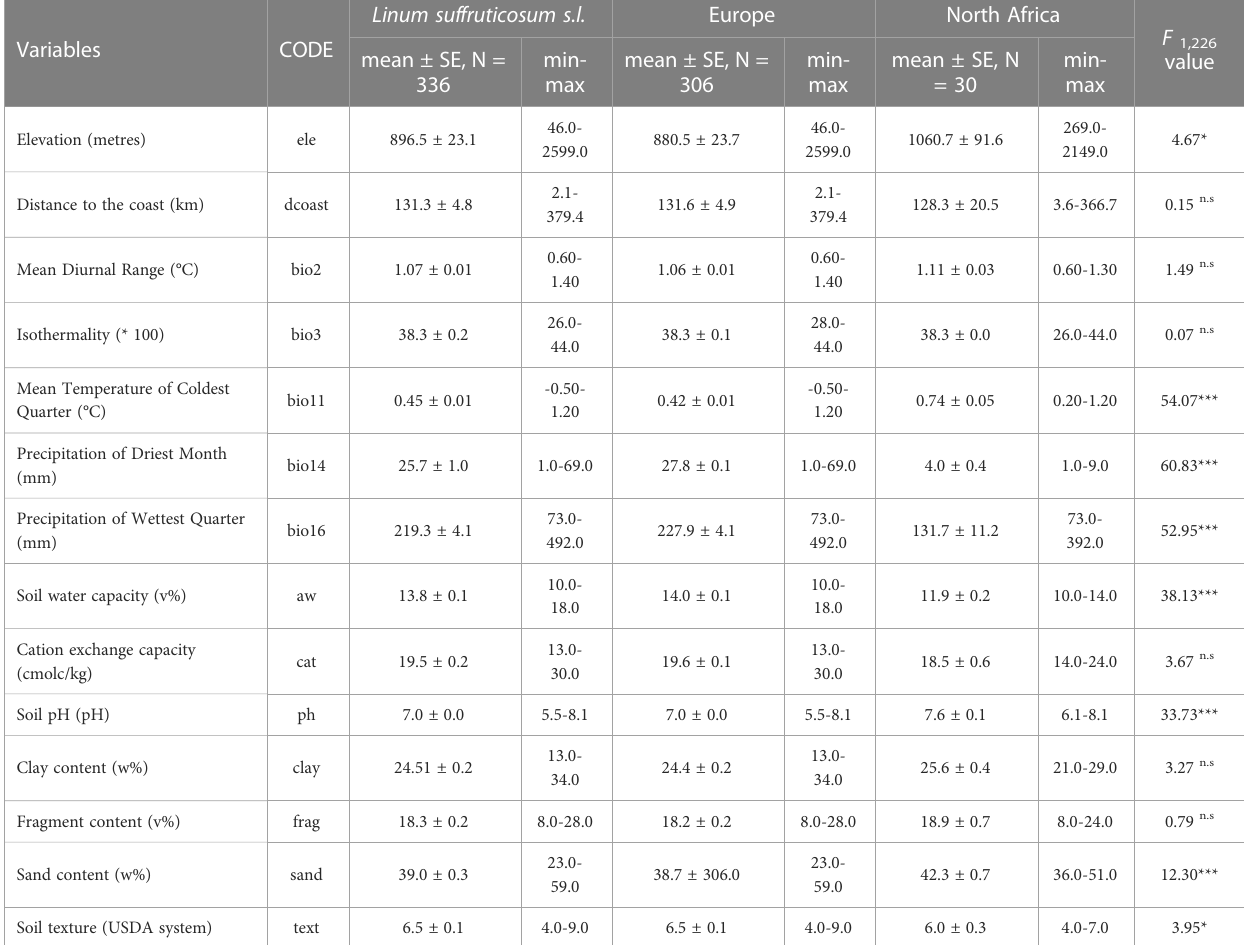
TABLE 1 Mean and standard error of the mean (mean ± SE) and minimum and maximum (min-max) values of selected variables used to characterise the niche of Linum suffruticosum s.l. in Europe and North